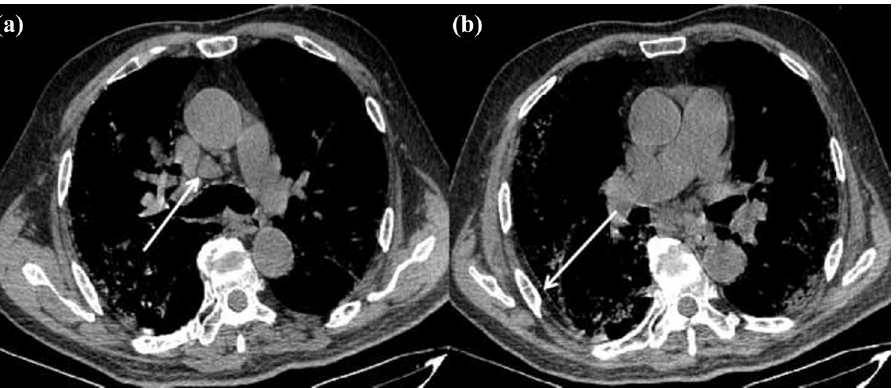
Figure 4: First CT scans ( axial mediastinal noncontrast image ) showing mediastinal enlarged lymph nodes ( white arrow, a ) and local thickening of the pleural ( white arrow, b )